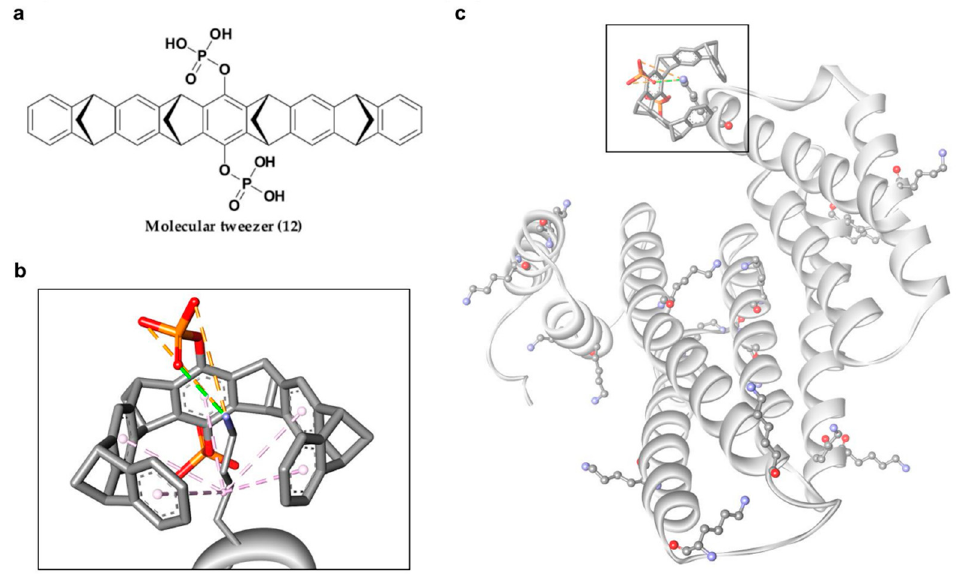
Figure 7. ( a ) Chemical structure of molecular tweezer inhibitor (12). ( b ) Mode of interaction between lysine residue and molecular tweezer inhibitor, with van der Waals interactions (purple dashed lines), hydrogen bond (green dashed line) and ionic interaction (orange dashed lines). ( c ) Representation of the 17 surface lysine residues of 14-3-3 σ (ball and stick), with molecular tweezer binding at the periphery (square box).